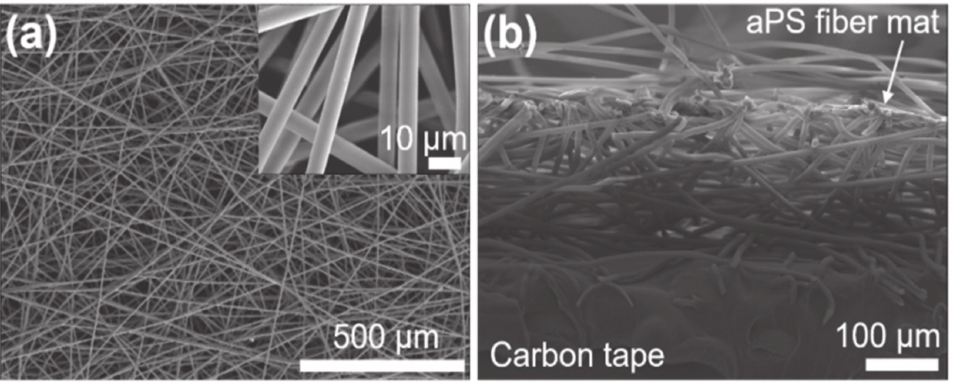
Figure 3. FESEM images of the aPS fiber mat: ( a ) top view and ( b ) cross-section view. Inset in ( a ) shows the enlarged FESEM image of the fiber mat with the top view.